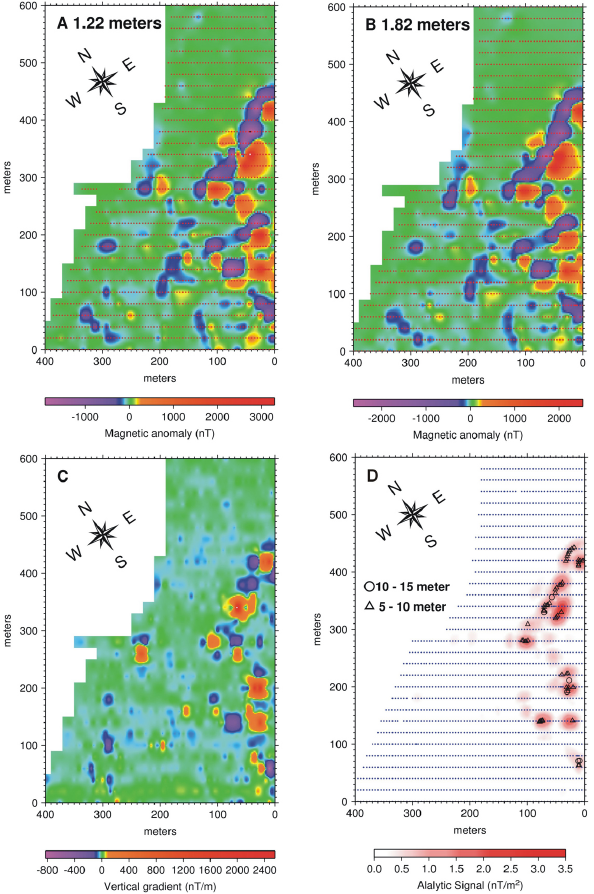
Fig. 4. Magnetic anomaly maps at (a) 1.22m and (b) 1.82m above the ground; (c) vertical gradients of magnetic fields obtained from the differences in magnetic data between (a) and (b) ; and (d) the first-order analytic signal together with source depth solutions (tri- angles and circles). Both red and blue dots indicate surveying points for magnetic data.